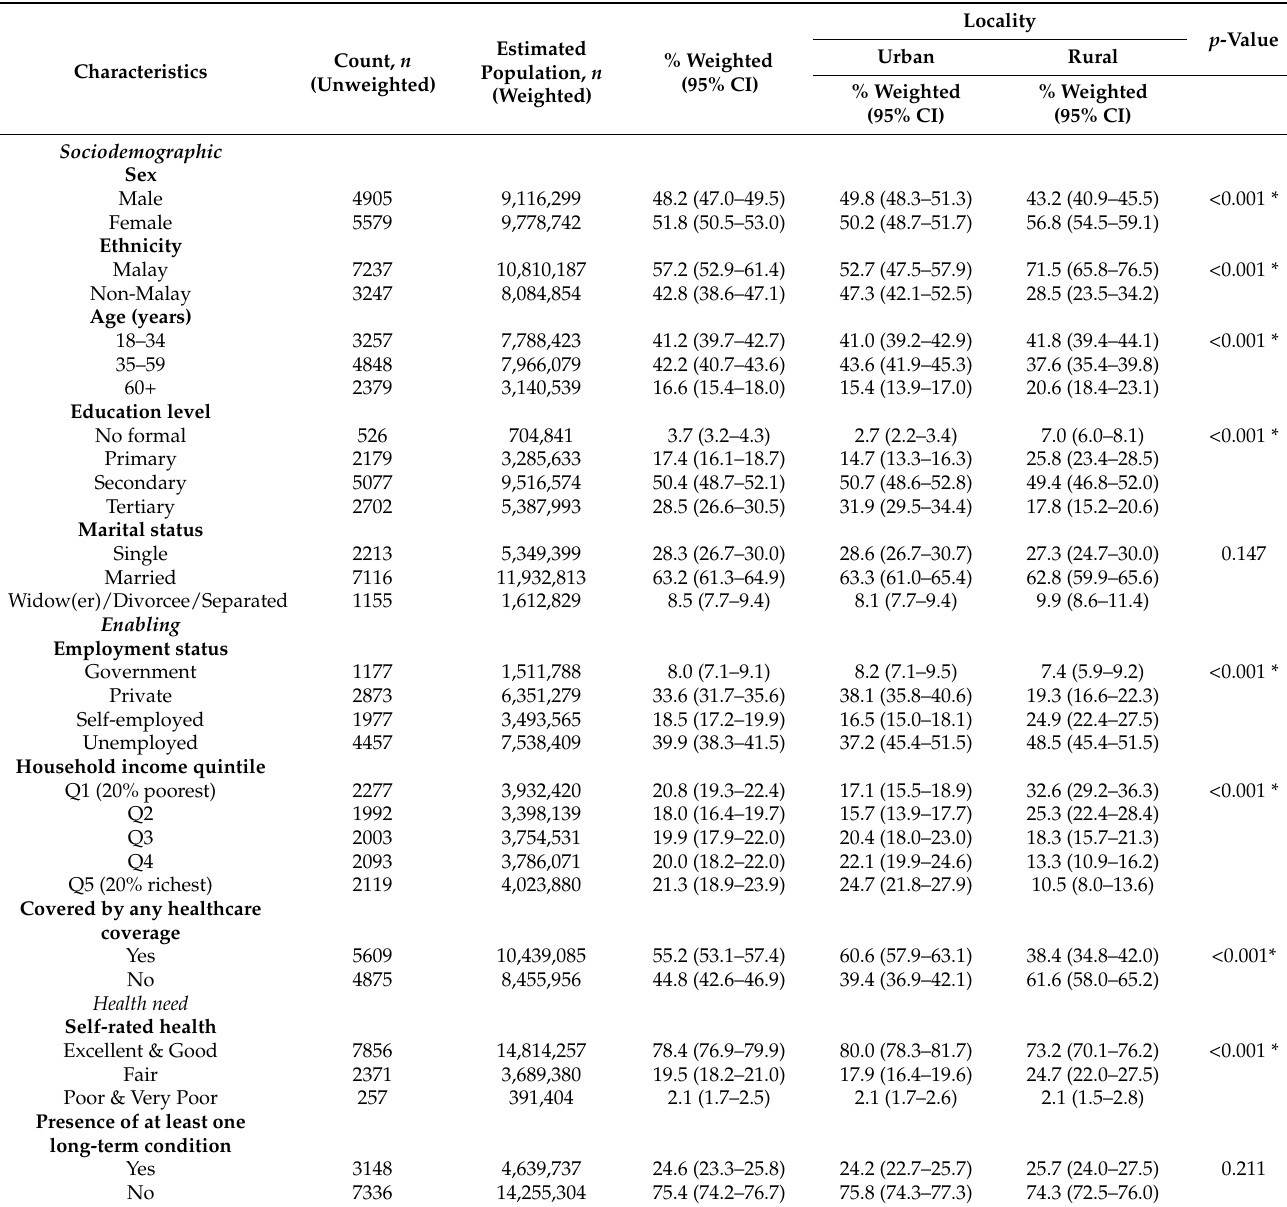
Table 1. Characteristics of respondents, stratified by urban-rural locality (N =